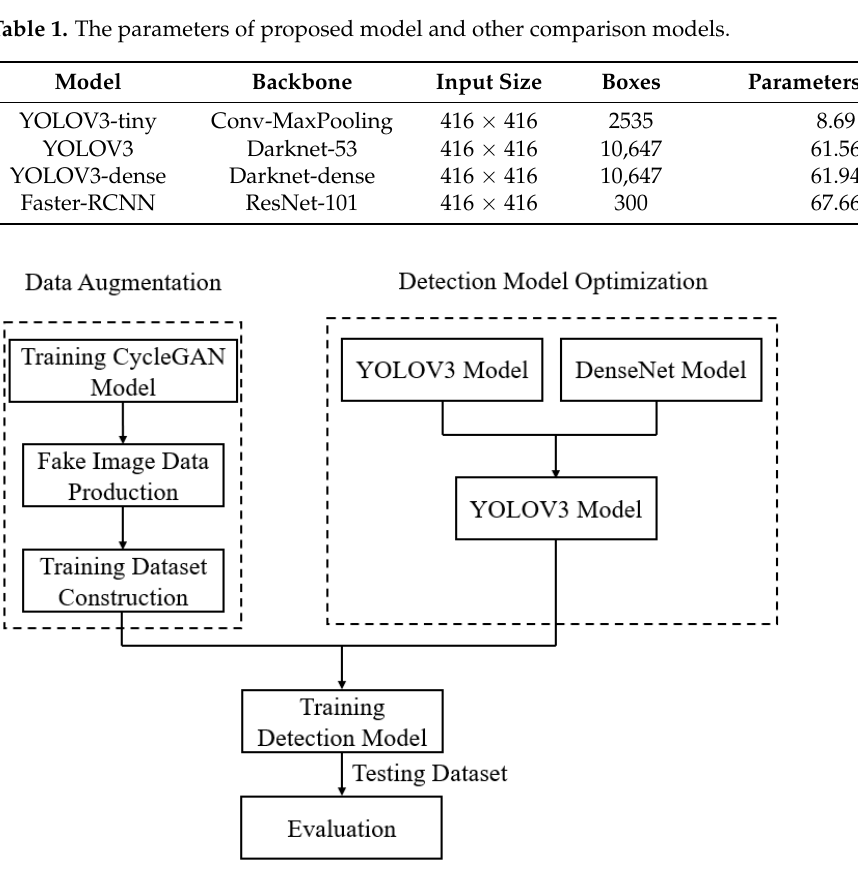
Figure 6. Flowchart of the